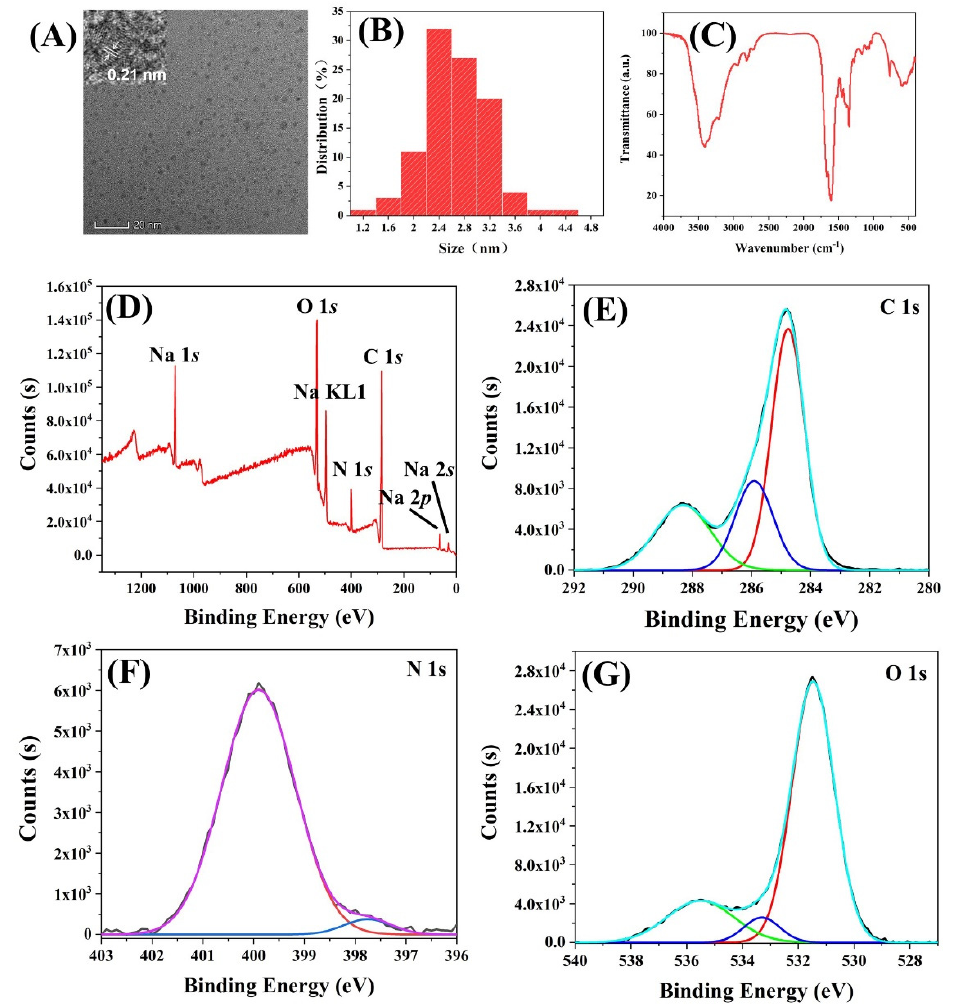
Figure 3. Characterization of rCDs; ( A ) the transmission electron microscope image; ( B ) the hydrodynamic size; ( C ) FTIR image; ( D ) survey XPS spectrum and high resolution of ( E ) C 1 s , ( F ) N 1 s , and ( G ) O 1 s .